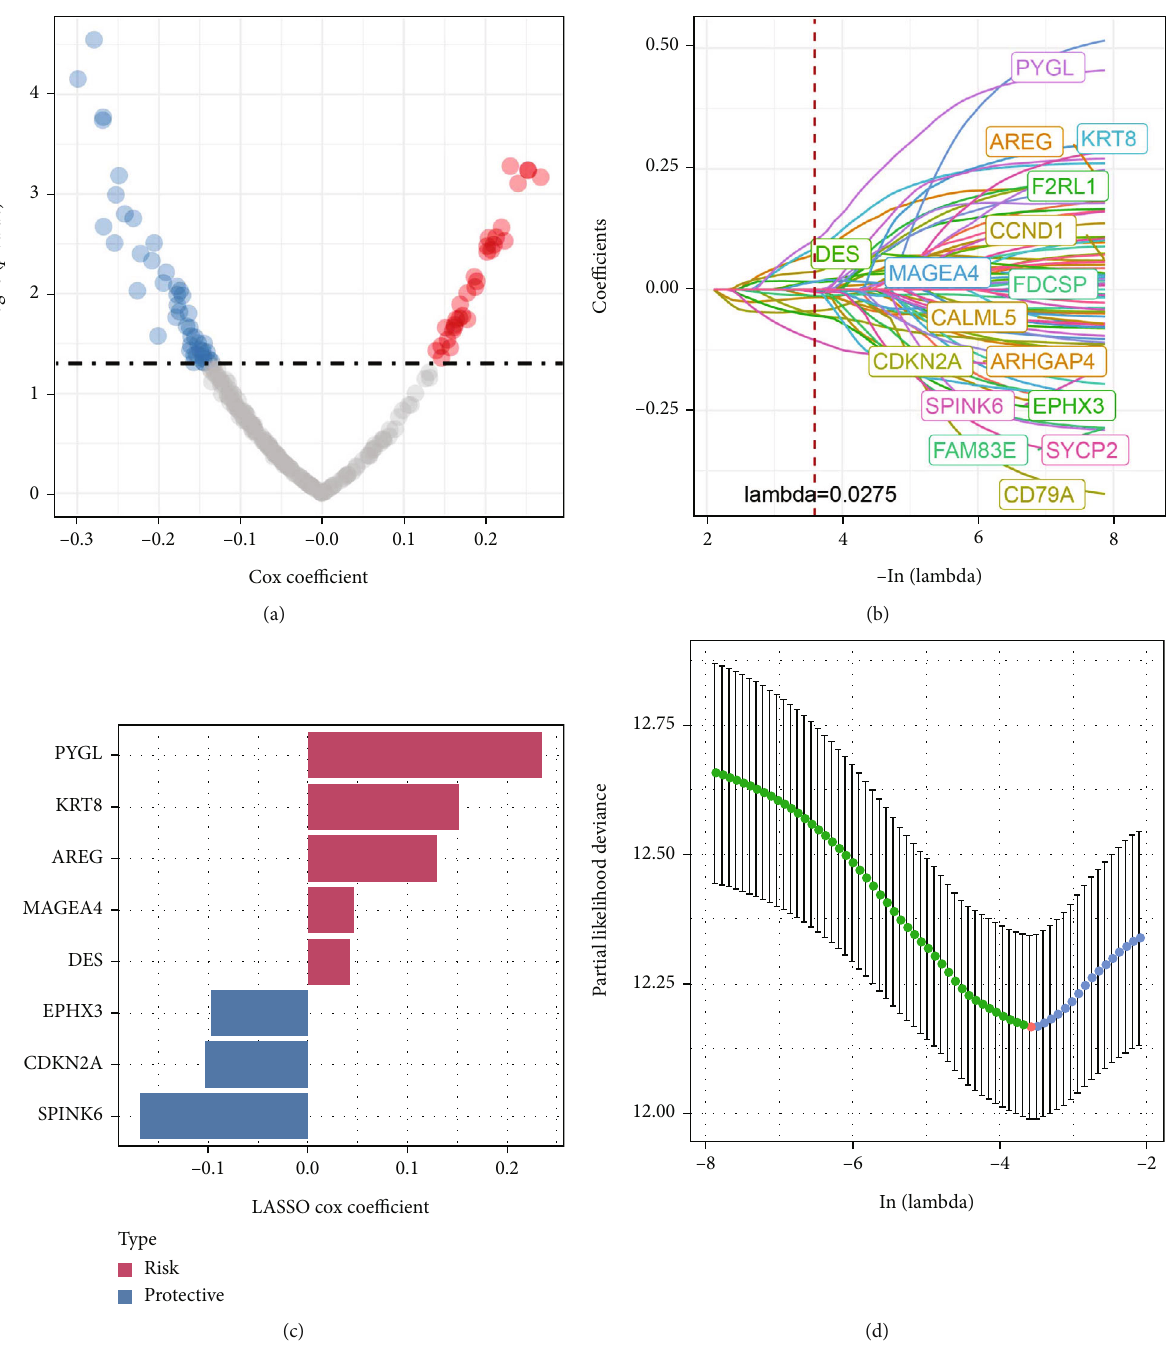
Figure 4: Identi fi cation of key cellular senescence-associated genes. (a) A total of 77 promising candidates were identi fi ed among the DEGs. (b) Trajectory of each independent variable with lambda. (c) Con fi dence interval under lambda. (d) LASSO coe ffi cient distribution of gene signature correlated with the